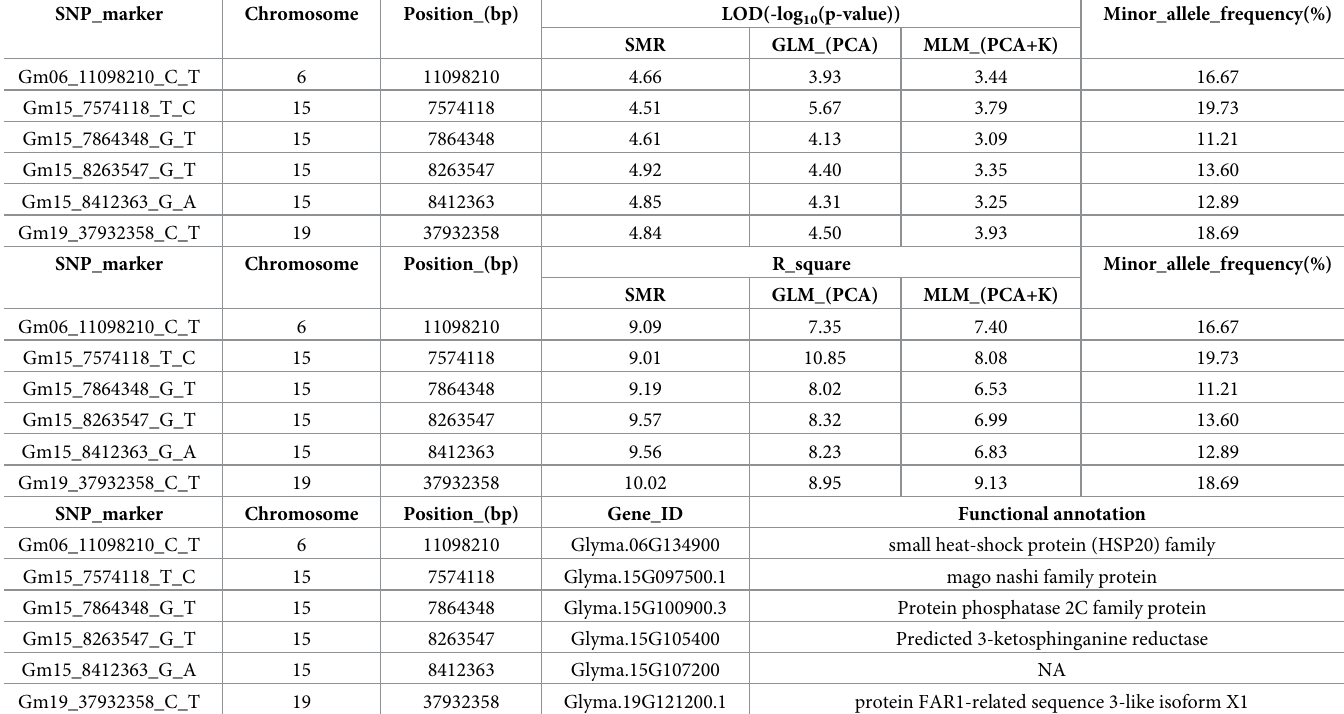
Table 4. Overlapping significant SNP markers (LOD > 3.00) between the Single Marker Regression (SMR), Generalized Linear Model_PCA (GLM_(PCA)), and Mixed Liner Model_PCA_K(MLM_(PCA+K))